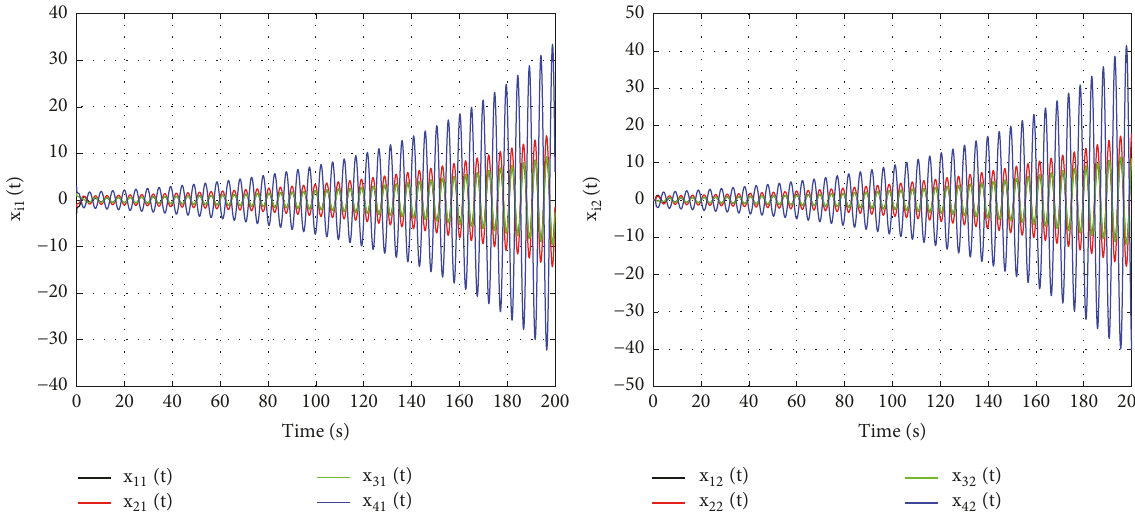
Figure 3: The trajectories of all agents’ states in the FOMAS with double integral and symmetric time-delays when all 𝜏 𝑚 > 𝜏 in Example 1.